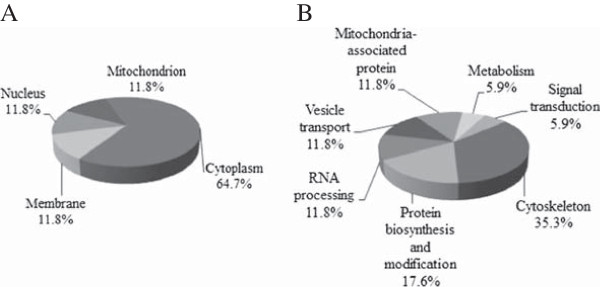
Pie chart representing differentially expressed proteins identified by mass spectrometry following TGEV infected ST cells. Proteins were classified according to their subcellular location (A) and biological function (B).